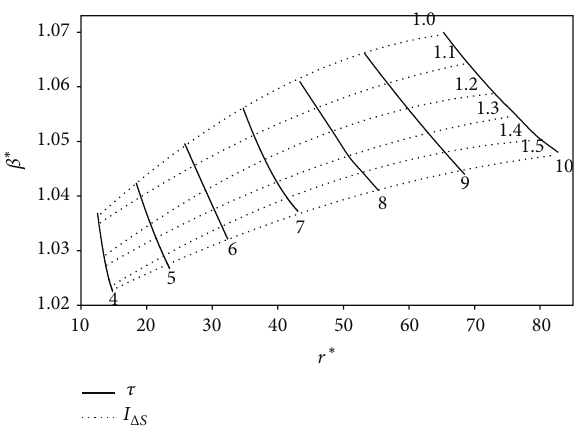
Figure 9: Variation of the optimum 𝛽 at ECOP based on the optimum 𝑟 , for various 𝜏 and 𝐼 Δ𝑆 values ( 𝑇 0 = 𝑇 𝐿 = 300 K, 𝑋 = 0.3 , and 𝜉 = 0.02 ).